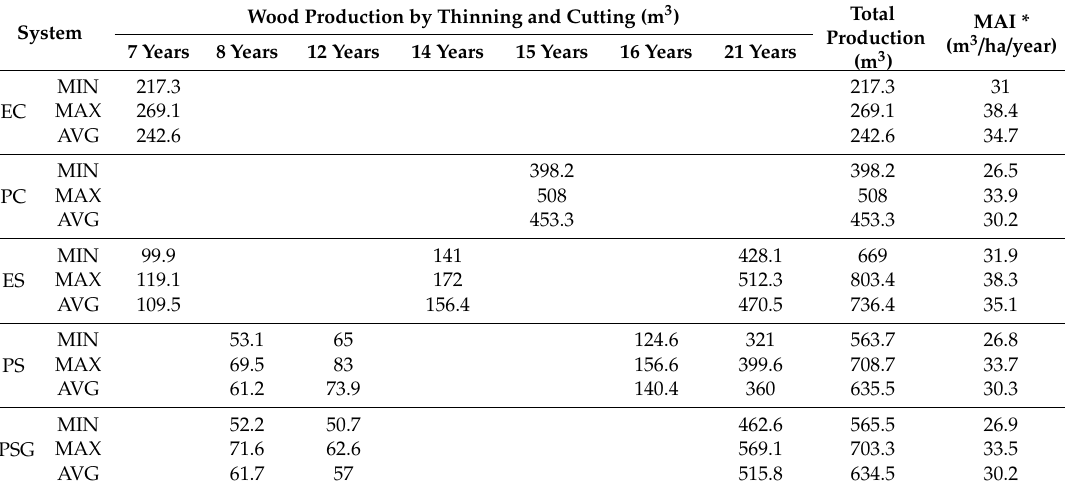
Table 2. Management and production volume of the